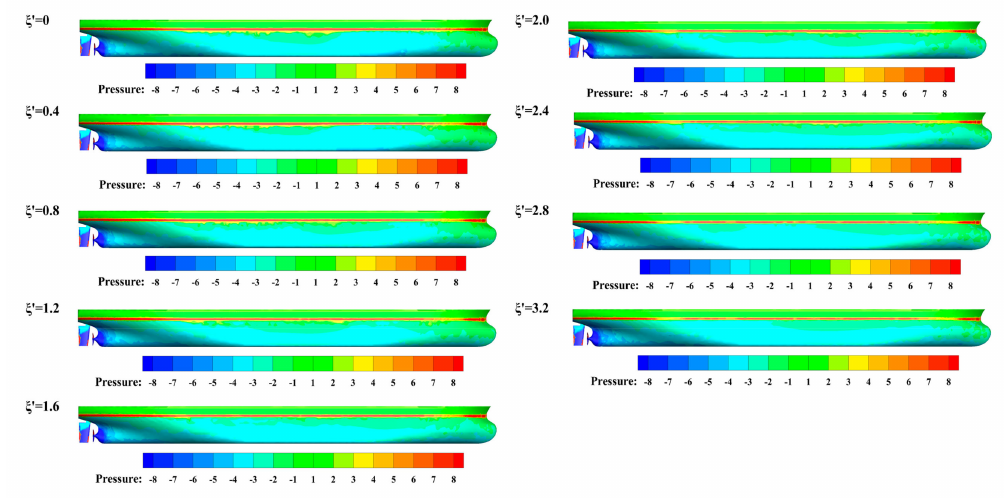
Figure 13. The dynamic pressure distribution on the right SOD hull surface, ξ (cid:48) =